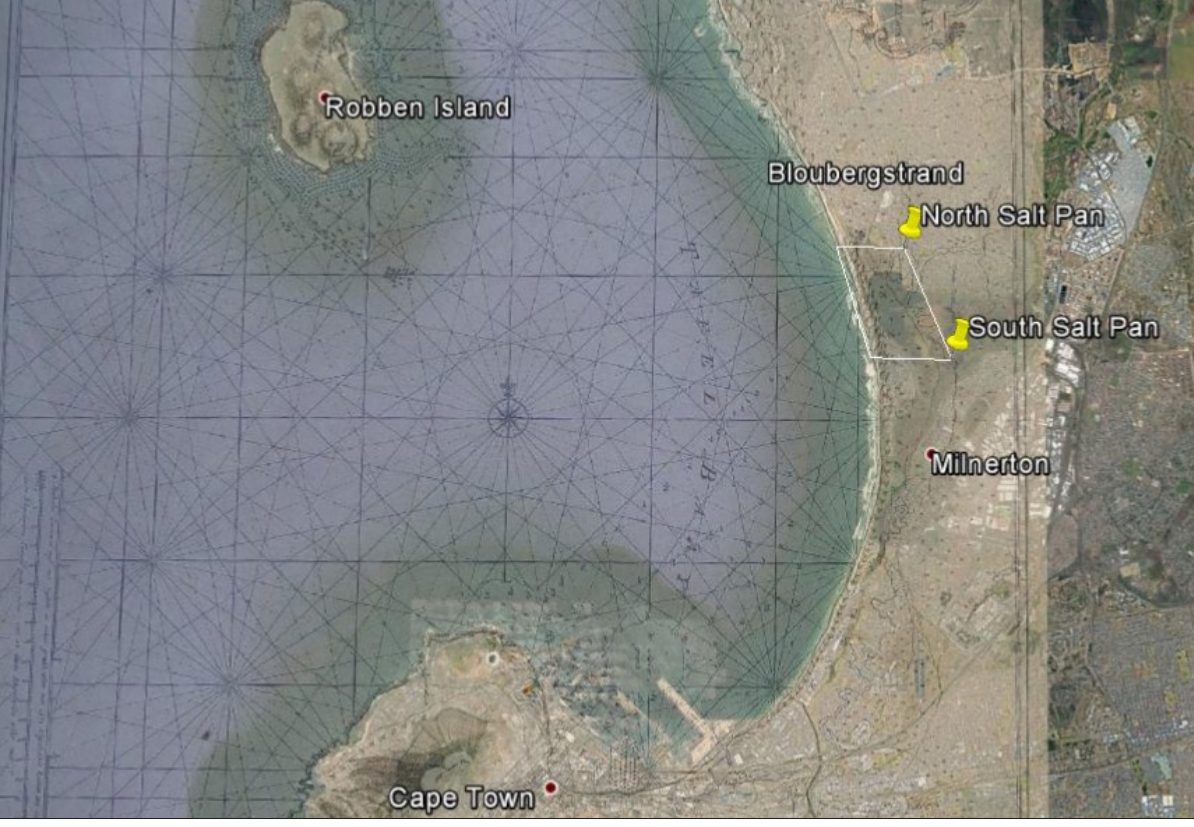
Photo: Mark Prowse ©AIMURE Figure 2: Map of Table Bay and the adjacent coast, by Joannes van Keulen, dating to 1753, overlaid with SAN chart 118, Table